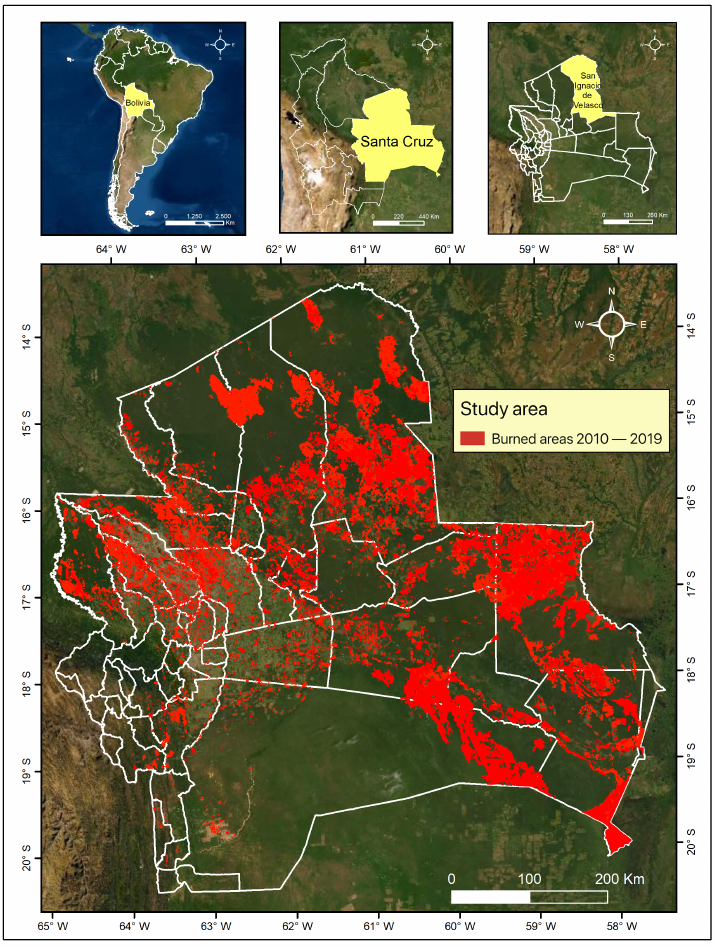
Figure 1. Study area: department of Santa Cruz in Bolivia with burned areas (2010–2019, from MODIS). The municipality of San Ignacio de Velasco is also indicated in the top-right map. Wildfires are historically recognized as part of the disturbance regime of the